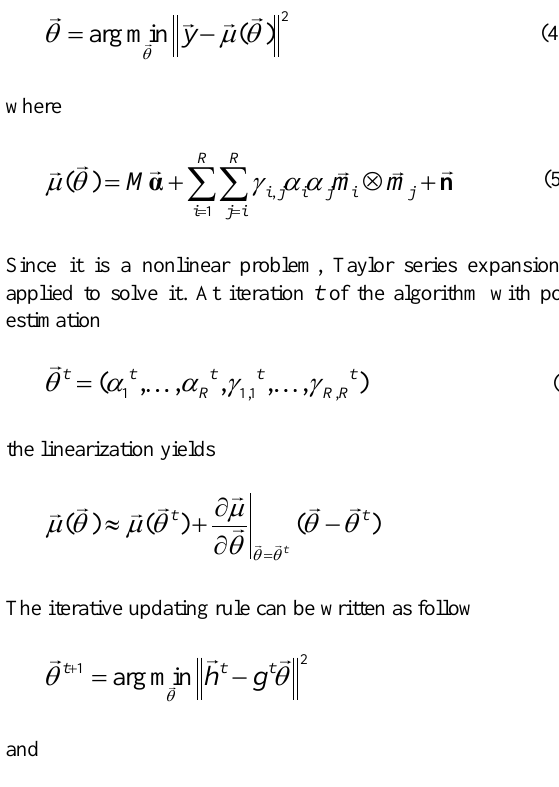
Figure 1. Hyperspectral image with ground truth in University of